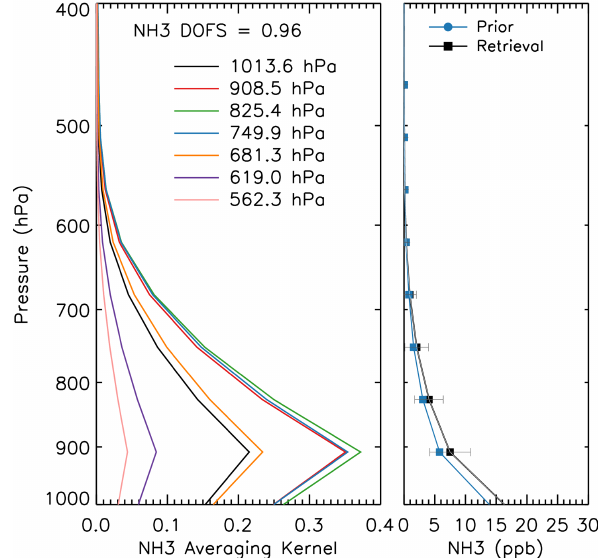
Figure 7. Averaging kernel from a CrIS retrieval from a measure- ment on 28 January 2013 over the San Joaquin Valley in California (left). A priori and retrieved profile with corresponding error bars are plotted in the right panel.